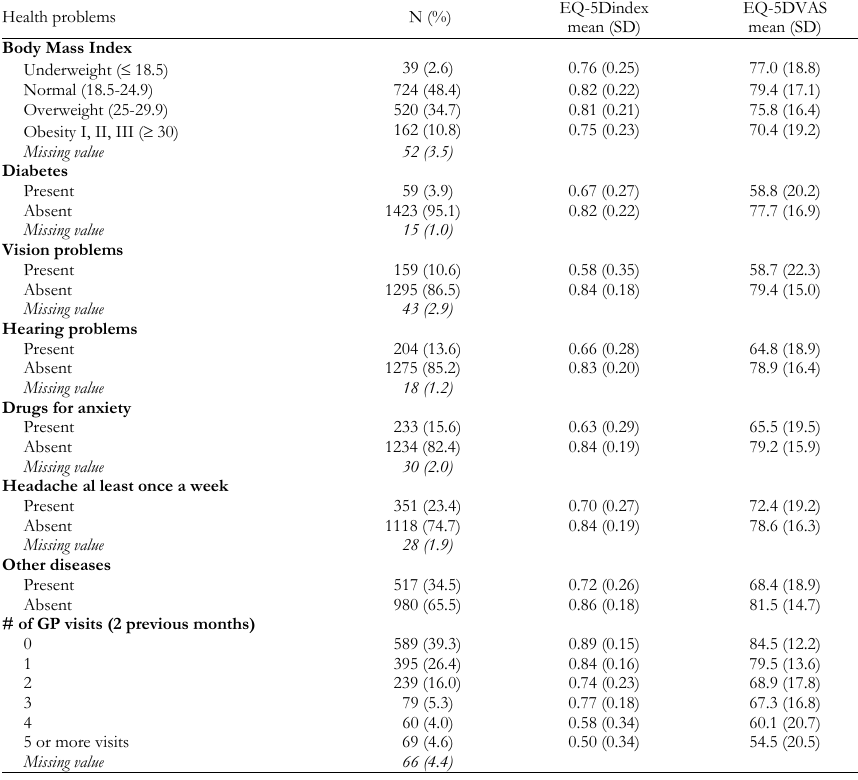
Health problems of the sample and EQ-5D index mean and standard